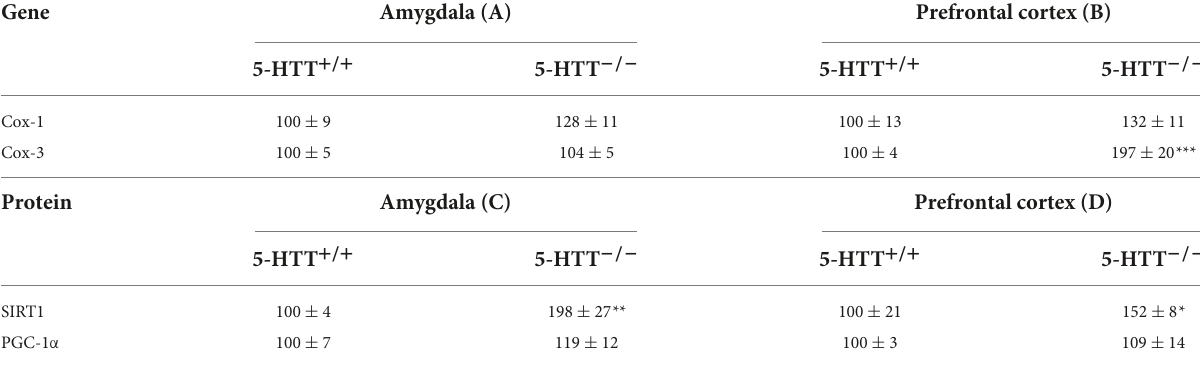
Thedataareexpressedasapercentageof5-HTT + / + (setat100%)andrepresentthemean ± SEMof7to10independentdeterminations.* p < 0.05,** p < 0.01,*** p < 0.001vs.5-HTT + / + (Unpaired t